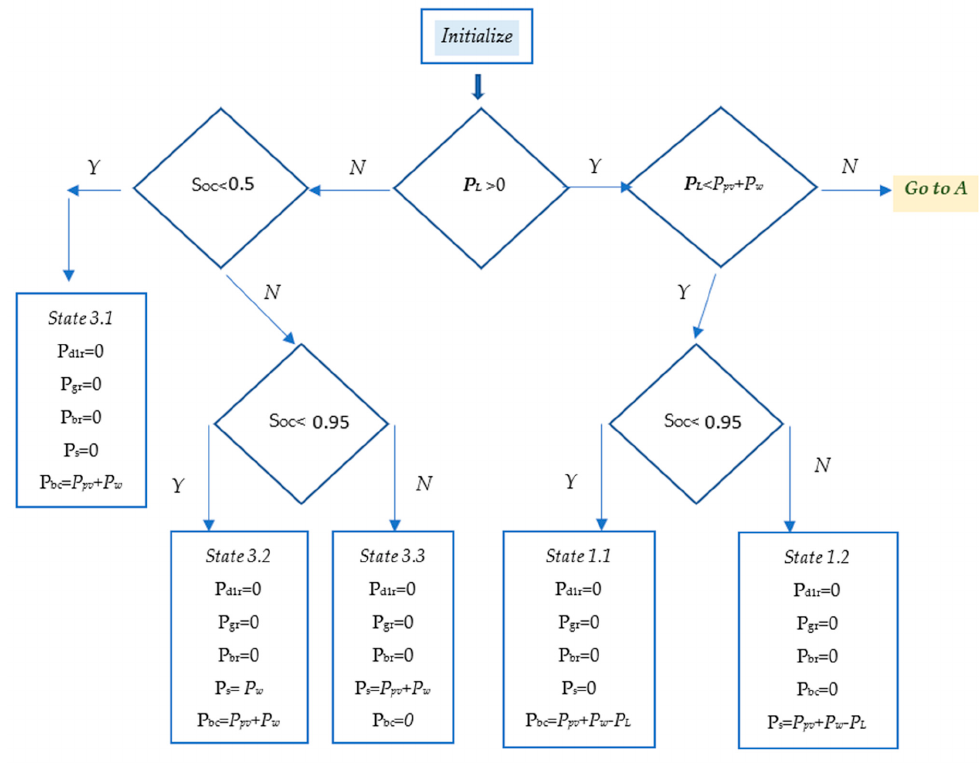
Energies 2021 , 14 , x FOR PEER REVIEW